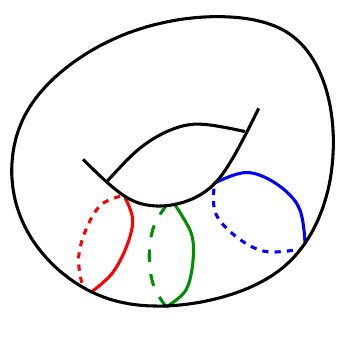
Figure 7 . Trisection diagram for M 4 = S 1 (cid:2) S 3